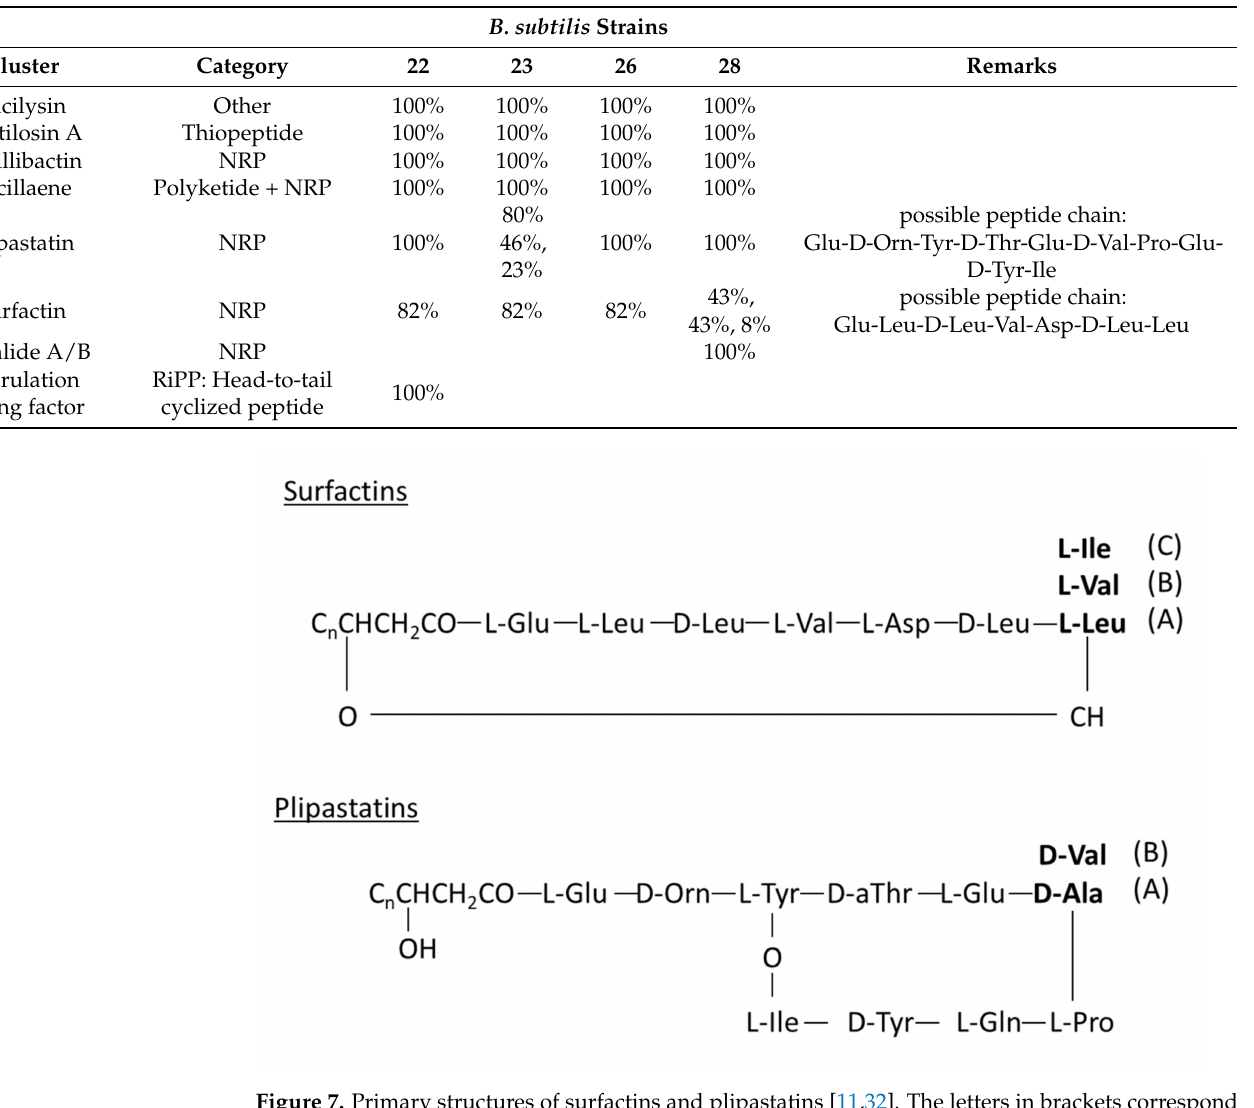
Table 3. Predicted gene clusters of NRP and other secondary metabolites by antiSMASH in the genomes of B. subtilis strains (number 22, 23 26, and 28). The percentage refers to the similarity of a gene cluster to a reference gene cluster.